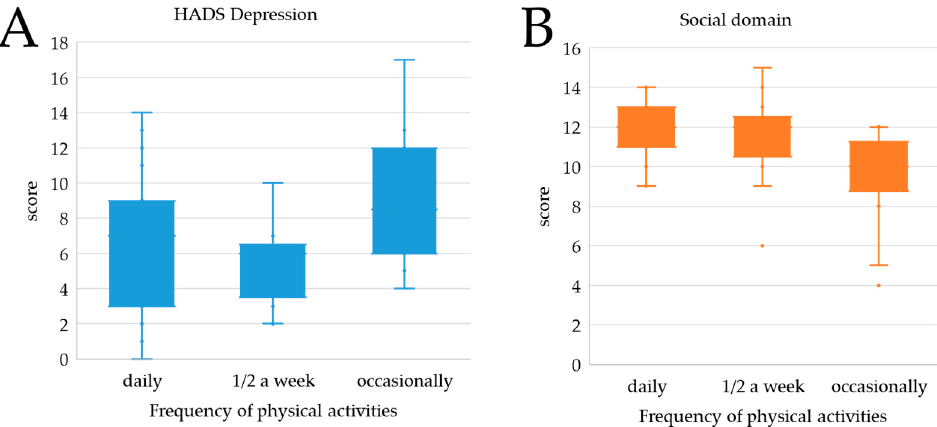
Figure 3. Relationship between depression ( A ), social domain ( B ), and physical activity in the group of men.